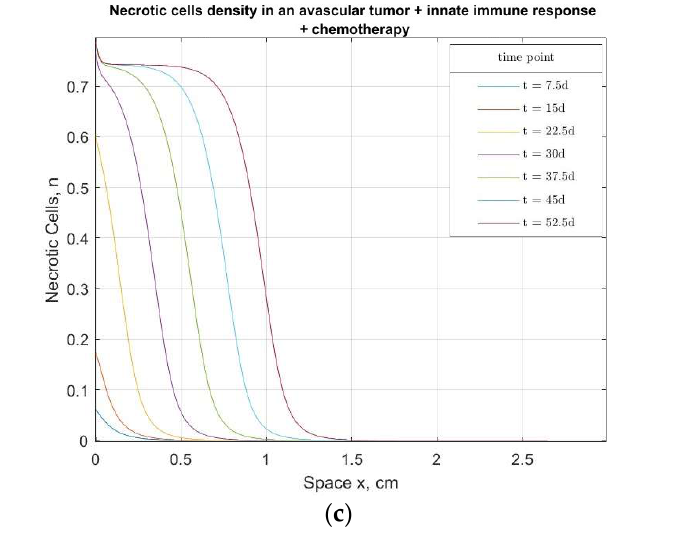
Figure 2. Numerical solutions for the necrotic cell density of an avascular tumor ( a ) without extratumoral interactions, ( b ) with the response of the innate immune system, ( c ) with the response of the innate immune system under the effect of chemotherapy, as functions of space x at times t = 0…52.5 days.